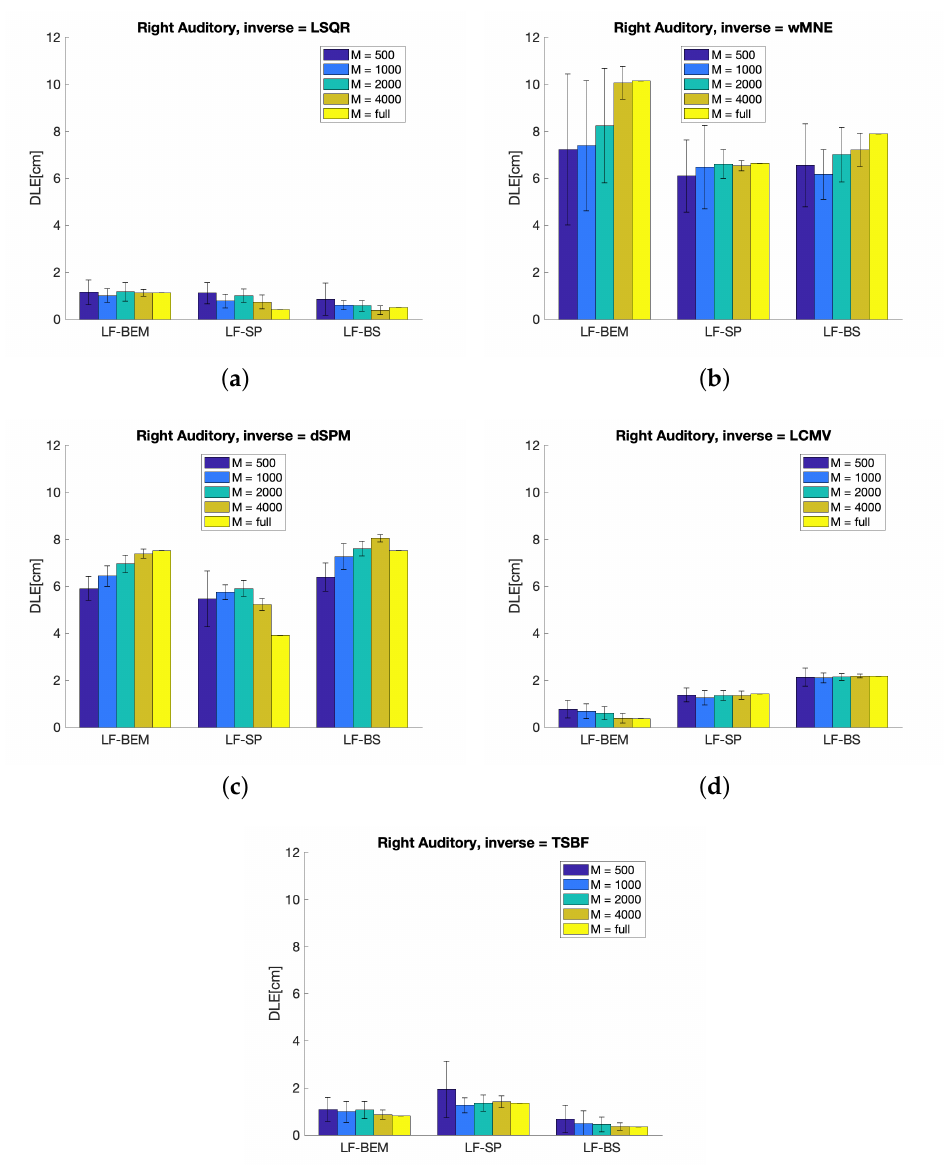
Figure 3. Right Auditory evoked field: Mean DLE [cm] and standard deviation obtained averaging over N = 10 runs using LSQR ( a ), wMNE ( b ), dSPM ( c ), LCMV ( d ), and TSBF ( e ) at 90 ms for LF-BEM, LF-SP, and